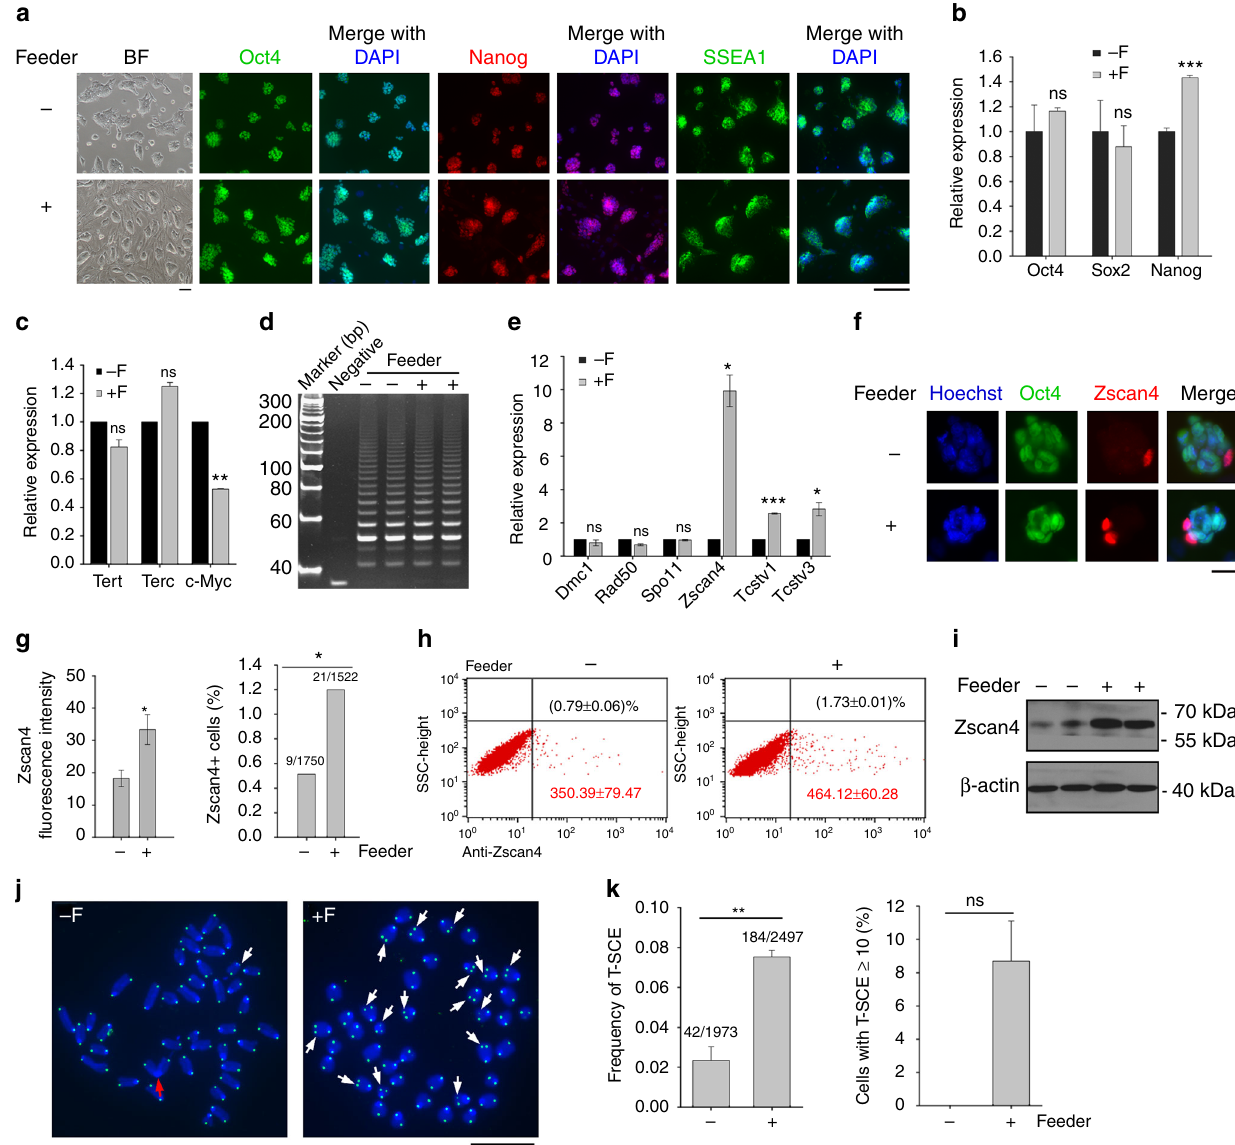
Fig. 2 Feeders increase Zscan4 expression and T-SCE in ESCs. a Morphology of F1 ESCs cultured in feeder or feeder-free conditions under bright fi eld (BF) with phase-contrast optics and immuno fl uorescence of pluripotency-associated markers Oct4, Nanog, and SSEA1. Scale bar, 100 μ m. b Expression by qPCR analysis of Oct4 , Sox2 , and Nanog in F1 ESCs cultured without ( − F) or with feeders ( + F). c Expression of telomerase-related genes Tert , Terc , and c-Myc in − F and + F ESCs. d Telomerase activity measured by TRAP assay. Lysis buffer served as negative control. e Expression by qPCR of genes for telomere recombination, Dmc1 , Rad50 , Spo11 , and 2C genes, Zscan4 , Tcstv1 , and Tcstv3 . f Immuno fl uorescence co-staining of Oct4 and Zscan4 shows Zscan4-positive cells mutually exclusive of Oct4. Scale bar, 20 μ m. g Relative Zscan4 fl uorescence intensity estimated by ImageJ and percentage of Zscan4 + cells (number of ESCs counted). h Flow cytometry quadrantal diagram indicates percentage and mean fl uorescence intensity of Zscan4 + cells in ESCs. i Western blot analysis of Zscan4 in − F and + F ESCs. j Representative CO-FISH images showing T-SCE (indicated by white arrows) in − F and + F ESCs. Red arrow, chromosome fusion. Scale bar, 10 μ m. k Frequency of T-SCE (total T-SCE/total chromosomes) and percentage of ESCs with T-SCE foci ≥ 10 in − F and + F ESCs. c – k N33 ESCs. Mean ± s.e.m. from three independent experiments. * P < 0.05, ** P < 0.01, *** P < 0.001, ns not signi fi cant ( P > 0.05). χ 2 test for g (right) and k , and Student ’ s t -test for b , c , e , g (left). − F without feeders, + F with